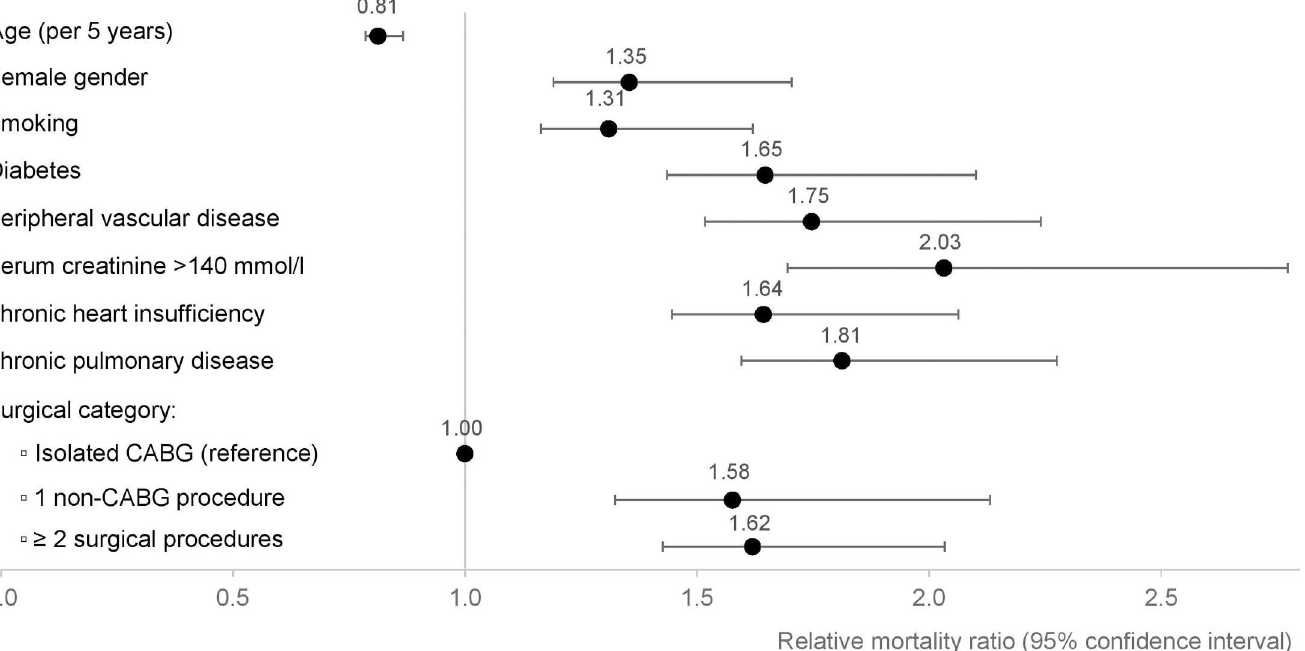
Fig 4. Predictors of relative mortality. Estimated relative mortality ratios (RMR) with corresponding 95% confidenceintervals (CI) for predictor variablesof long-term relative mortality in patients undergoingcardiac surgery. A ratio of 1 indicates no difference. CABG, coronary artery bypass